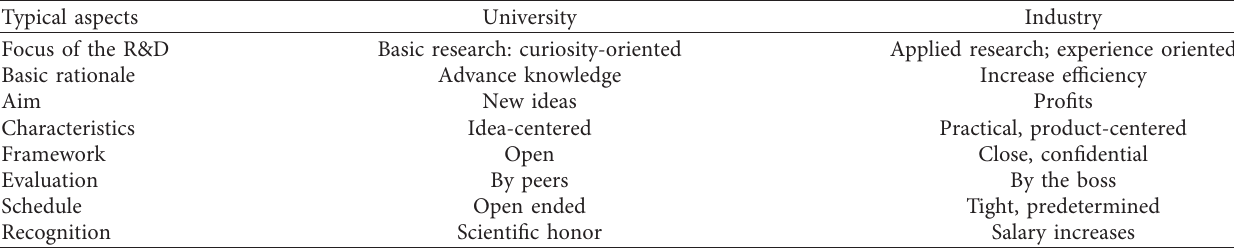
Table 1: Difference between academic and industrial research (source: